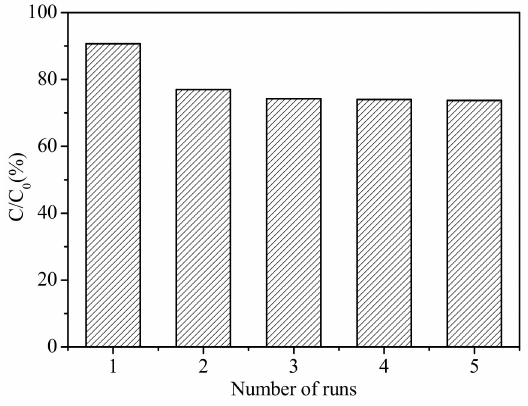
Figure 9. Recycling test for the photocatalysis of p-nitrobenzoic acid by Ba(II)/TiO 2 –MCM-41 (reaction conditions: C 0 = 4 × 10 -4 mol/L, dosage of material = 0.5 g/L, reaction time: t = 60 min, initial pH = 4.0 ±